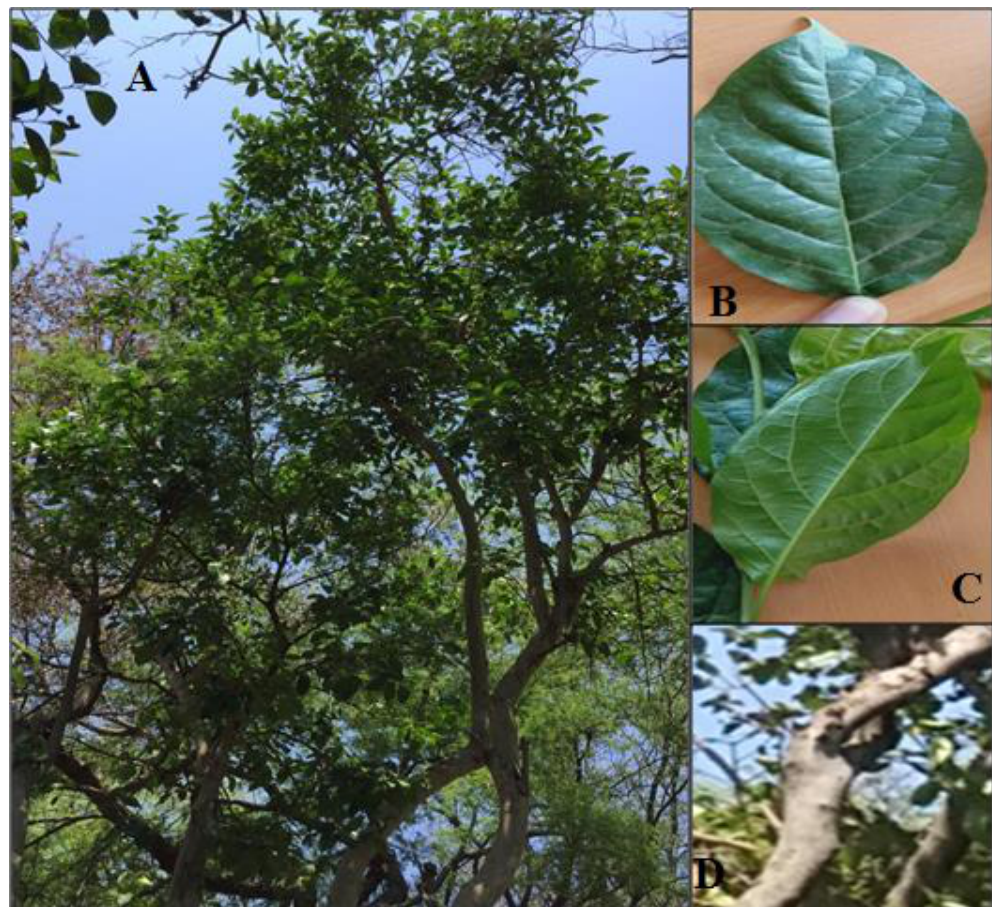
Figure 1. E. laevis tree; ( A ) dark green leaf; ( B ) leaf venation; ( C ) stem-bark ( D ).